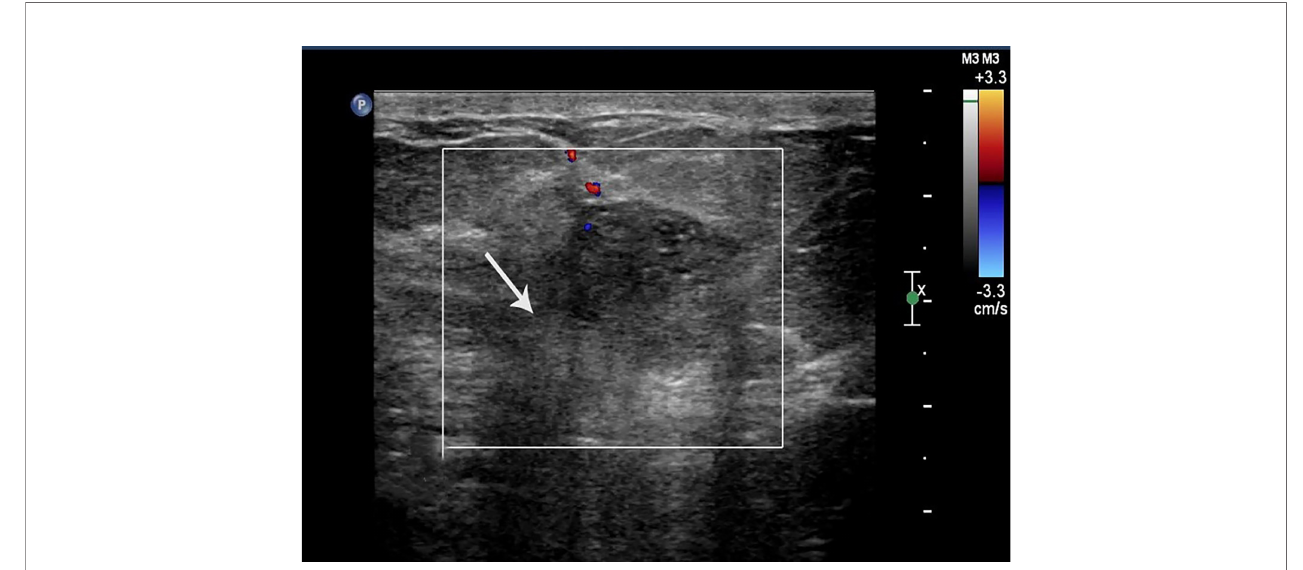
FIGURE 1 | Case 2: A 55-year-old woman with MMBC presented with a hypoechoic mass (1.9 × 1.6 × 1.5cm) in the right breast. The mass presented with a non-circumscribed margin (white